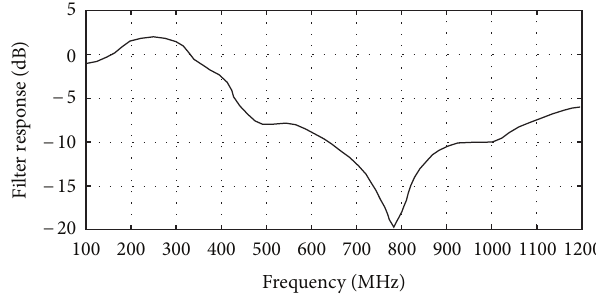
Four 5 cm × 5 cm apertures without coating Four 5 cm × 5 cm apertures with internal coating